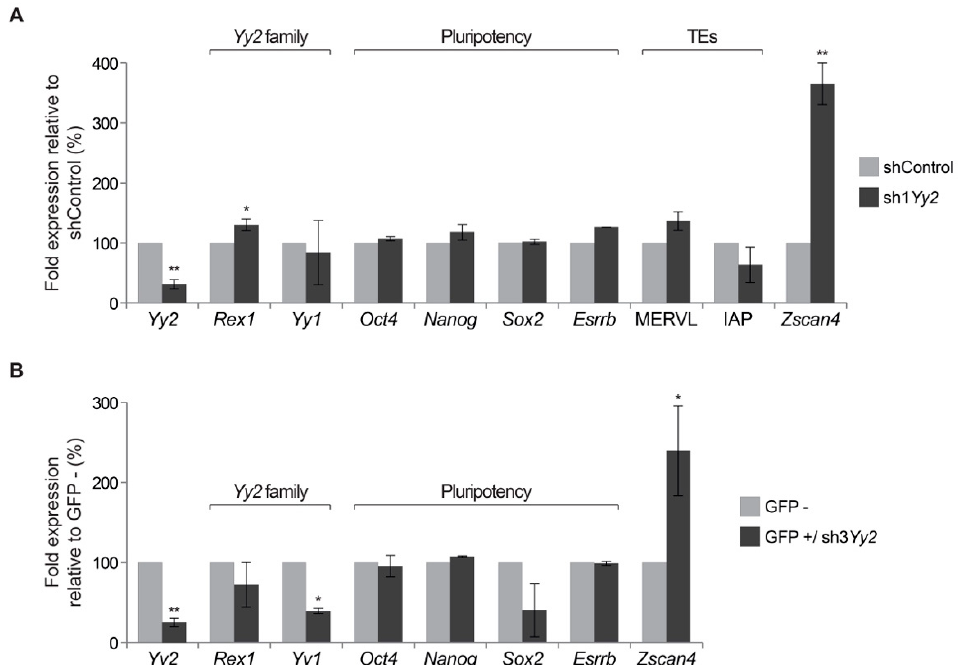
Figure 4. Gene expression in Yy2 -depleted mESC. ( A ) Gene expression in mESC colonies transfected with either sh1 Yy2 - or shCon-expressing plasmids was measured by qPCR. Expression levels are depicted as fold expression in depleted cells relative to mESC-expressing shControl. Data presented for sh1 Yy2 are the mean of 3 biological replicates, each performed on different days and using a different preparation of cells (except for Yy1 and Esrrb data that correspond to two replicates and one experiment, respectively), and three technical replicates for each experiment. The statistical significance (one sample t -test) of differences in gene expression is indicated, ** p -value ≤ 0.01, * p -value ≤ 0.05; all other differences were not significant. ( B ) Expression levels of Yy2 gene family members, pluripotency markers, and Zscan4 , measured in cells transfected with a GFP-expressing sh3 Yy2 construct. Cells were sorted based on GFP expression, and expression is depicted as fold expression of GFP+ relative to GFP- cells. Data shown are based on technical replicates. ** p -value ≤ 0.01, * p -value ≤ 0.05 (one sample t -test).